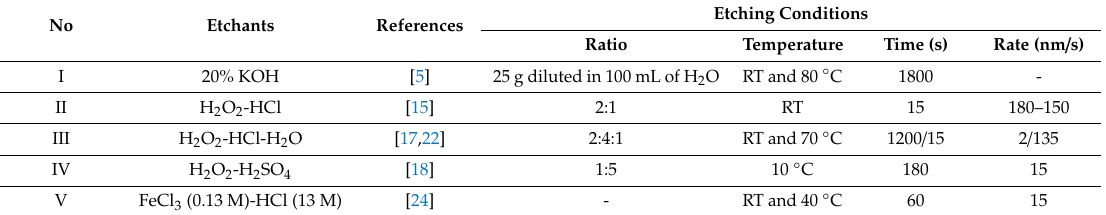
Table 2. Etchants used for revealing etch pits in (100) GaSb epilayer. RT (room